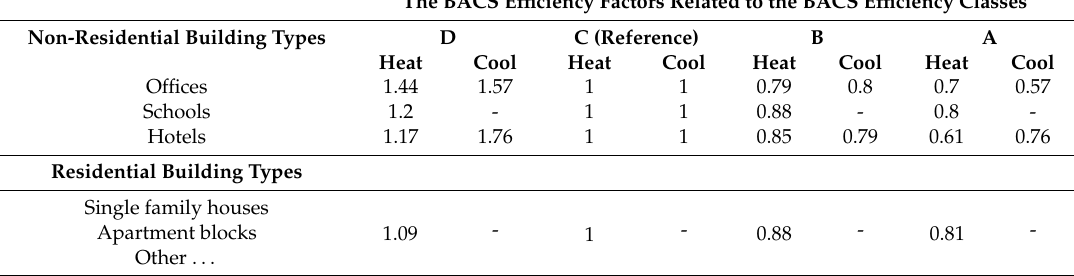
Table 4. The selected BACS efficiency factors for heating and cooling—non-residential and residential buildings. (Heat—Heating,